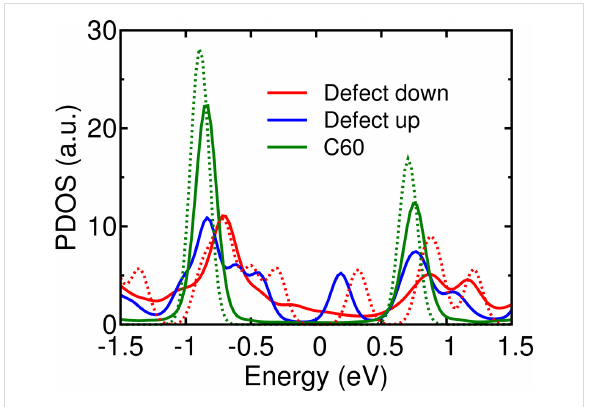
Figure 5: Calculated DOS of fullerenes with and without vacancy defects adsorbed on Au(111). In the case of defects, the molecule was adsorbed with the vacancy close to the surface (“defect-down”) or towards the vacuum layer (“defect-up”). The DOS of isolated mole- cules are shown as dashed